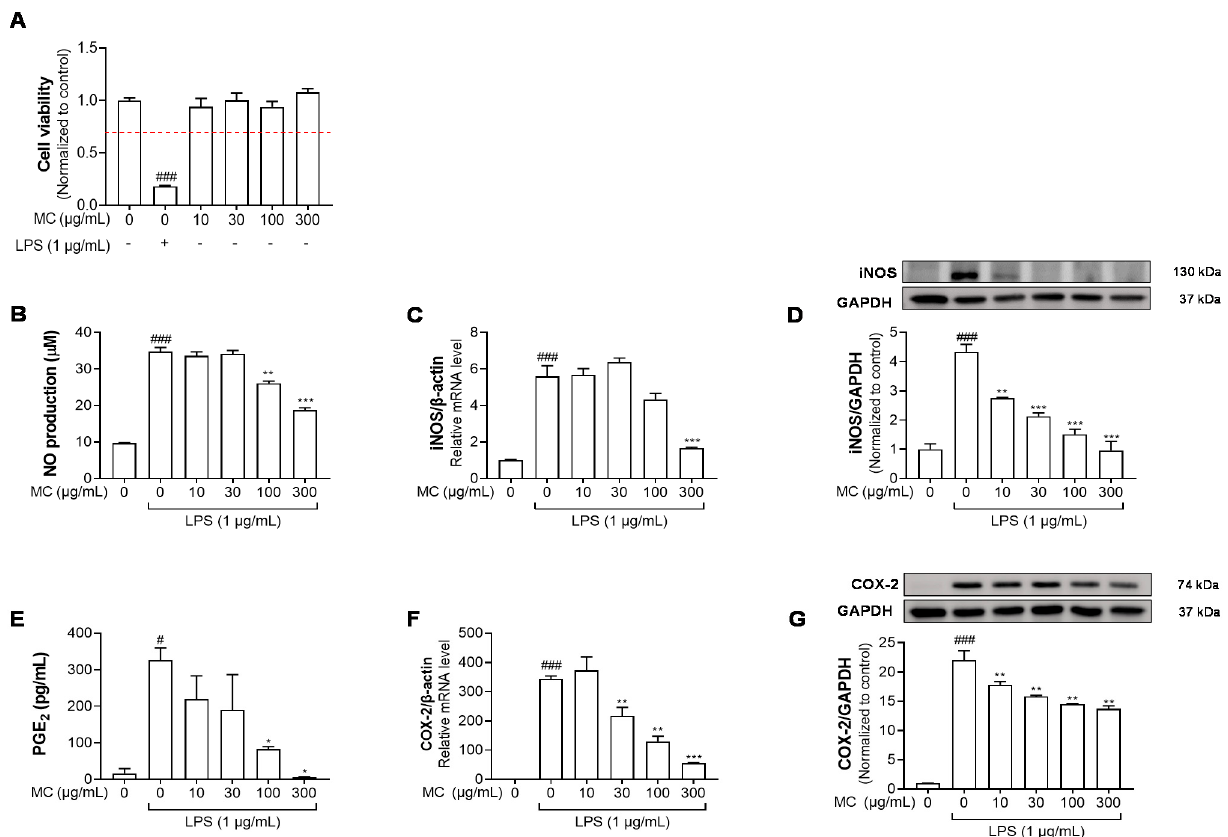
Figure 2. Effects of M. concanensis on the inflammatory response of LPS − stimulated HaCaT cells. HaCaT cells were treated with M. concanensis (MC) for 24 h, and cell viability was determined by MTT assay ( A ). Cells were pretreated with MC for 1 h before LPS stimulation (1 μ g/mL) for 24 h. The production of NO and PGE 2 was determined by Griess reagent and ELISA kits, respectively ( B , E ). The level of mRNA expressions of iNOS and COX-2 was determined by RT ‒ qPCR ( C , F ). The levels of iNOS and COX-2 proteins were measured by Western blotting analysis, and the quantifications were normalized to the control ( D , G ). The data presented are mean of three independent determinations and indicate the mean ± S.E.M. # p < 0.05, ### p < 0.001 compared to the vehicle-treated controls; * p < 0.05, ** p < 0.01 and *** p < 0.001 compared to the LPS-treated group.